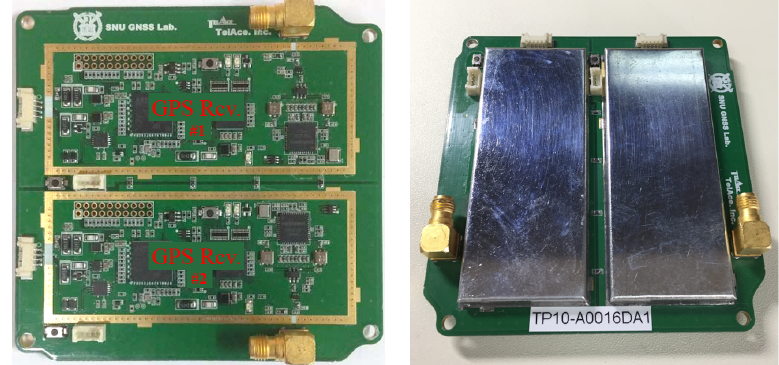
Figure 2. L1/L2C dual-frequency Global Position System (GPS) receiver (2 units) for the